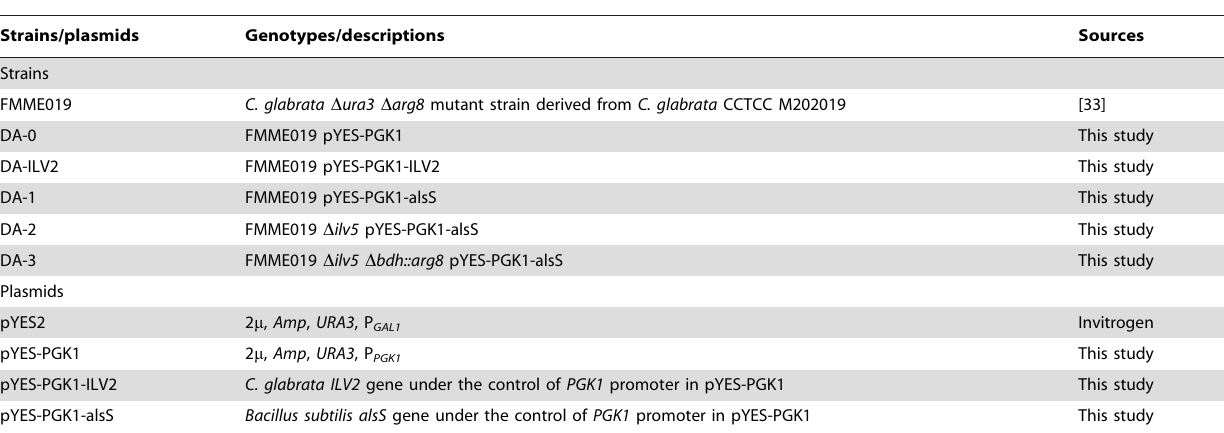
Table 5. Candida glabrata strains and plasmids used in this